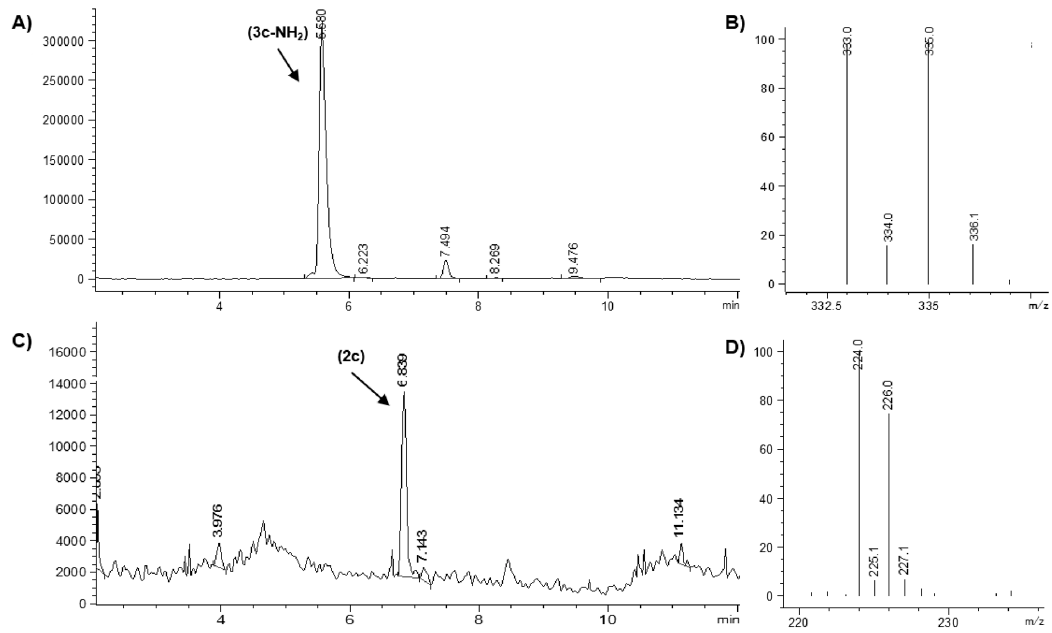
Figure 6. LC / MS analysis of the chemical reduction of model HAP 3c . ( A ) Extracted ion chromatogram Figure 6. LC/MS analysis of the chemical reduction of model HAP 3c . A) Extracted ion chromatogram at m / z 333 corresponding to the Br-79 isotopologue of the amino derivative of 3c . ( B ) Mass spectrum of at m/z 333 corresponding to the Br-79 isotopologue of the amino derivative of 3c . B) Mass spectrum peak at 5.580 min. ( C ) Extracted ion chromatogram at m / z 224 corresponding to the 79 Br isotopologue of peak at 5.580 min. C) Extracted ion chromatogram at m/z 224 corresponding to the 79 Br isotopologue of 2c from injection of a 1.8 µ M solution. ( D ) Mass spectrum of peak at 6.839 of 2c from injection of a 1.8 μ M solution. D) Mass spectrum of peak at 6.839 min.